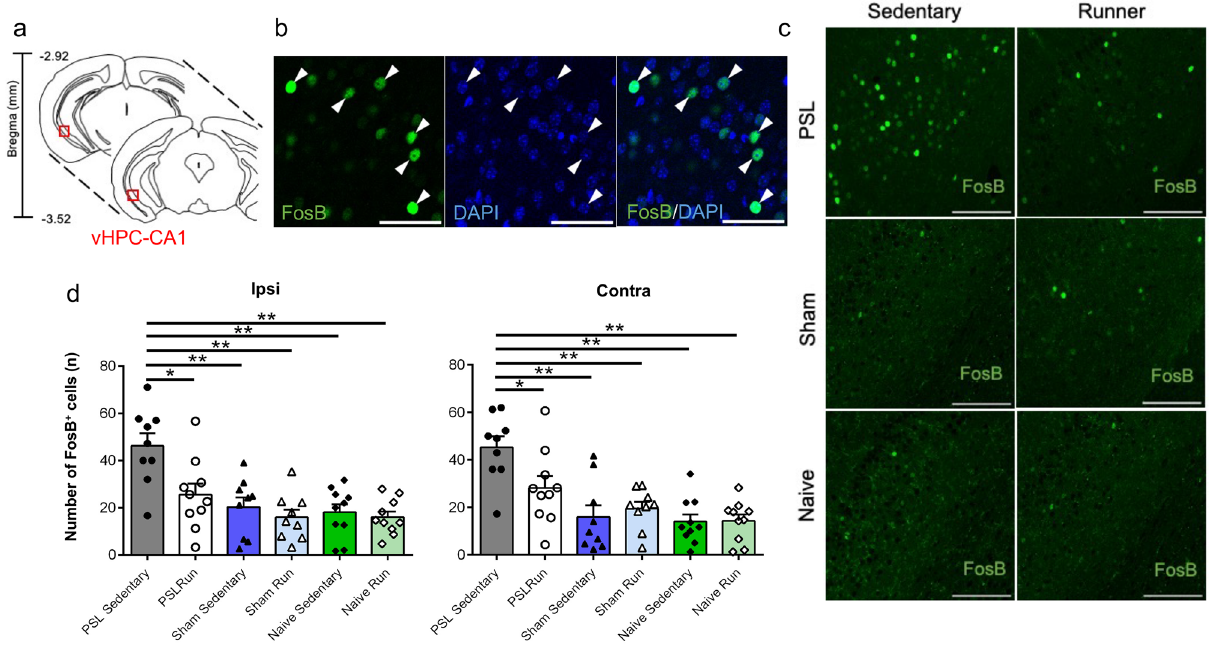
Figure 3. Effects of PSL and voluntary running on FosB + cells in the vHPC-CA1. ( a ) Representative coronal brain images including the vHPC-CA1. The vHPC-CA1 is highlighted by the red squares. ( b ) Photomicrograph showing FosB + (green)/DAPI (blue) immunoreactivities in the vHPC-CA1. The arrowheads indicate activated cells marked by double staining with FosB antibody and DAPI. Scale bar = 50 μm. ( c ) Photomicrographs showing FosB (green) immunoreactivity in the vHPC-CA1. Many FosB + cells in the vHPC-CA1 were detected in PSL-Sedentary mice compared to other experimental groups. Scale bars = 100 μm. ( d ) Bar charts showing the number of FosB + cells in the vHPC-CA1 in all experimental groups. The number of FosB + cells in the vHPC-CA1 in PSL-Sedentary mice was significantly increased on both the ipsilateral and contralateral sides of the PSL surgery. Bars represent mean ± SEM. A two-way analysis of variance followed by Tukey’s post hoc-test was used to compare the number of FosB + cells among the experimental groups. *p < 0.01, **p < 0.001. n = 9–10. PSL partial sciatic nerve ligation, SEM standard error of the mean, vHPC ventral